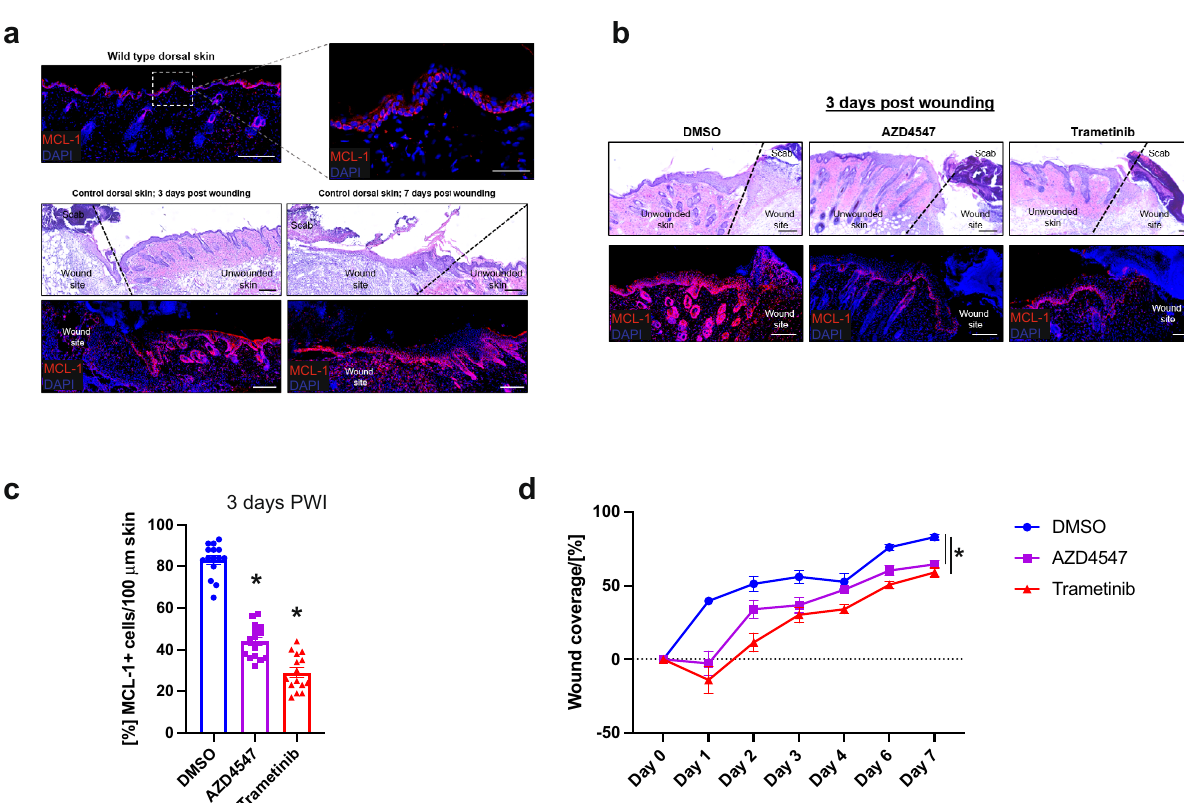
Fig. 7 FGFR and MEK inhibition decreases MCL-1 expression and hinders wound repair. a H & E and immunostaining of MCL-1 in unwounded skins and 3 or 7 days post wounding (PWI). Representative image of n = 15 mice, Scale bar: 200 µ m, Inset 50 µ m. The wound edge is indicated with a black broken line. b H & E and immunostaining of MCL-1 in skins 3 days post wounding in DMSO or inhibitor treated mice as indicated. Representative image of n = 15 mice per group, Scale bar: 200 µ m. The wound edge is indicated with a black broken line. c Quanti fi cation of MCL-1 positive cells in the area surrounding the wound site. n = 15 mice per group, each dot represents an individual mouse, mean values ± s.e.m.; * p < 0.0001 compared to DMSO; Tukey corrected one-way ANOVA. d Quanti fi cation of dorsal wound coverage in DMSO or inhibitor treated mice over a 7-day period. N ≥ 2 mice per group, each dot represents an individual mouse, mean values ± s.e.m.; Tukey corrected one-way ANOVA at day